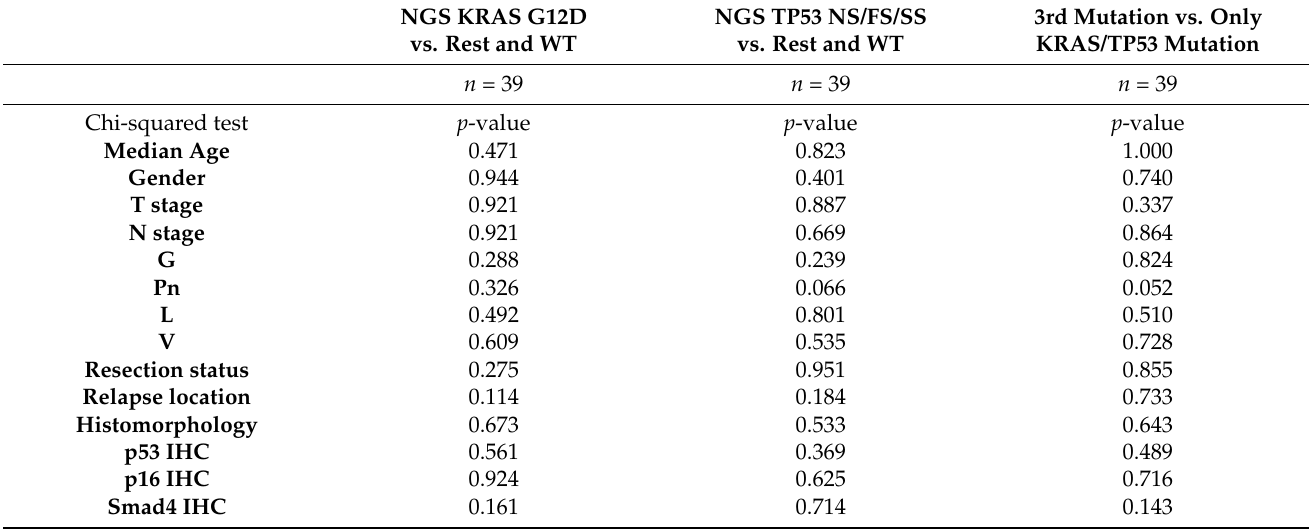
Table 2. Correlation analysis between clinicopathological variables and mutations. Chi-squared test ( p -value < 0.05 indicates significance). There was a homogenous distribution of clinicopathological, histomorphological and immunohistochemical variables across mutation subgroups. NGS KRAS G12D NGS TP53 NS/FS/SS 3rd Mutation vs. Only vs. Rest and WT vs. Rest and WT KRAS/TP53 Mutation n =